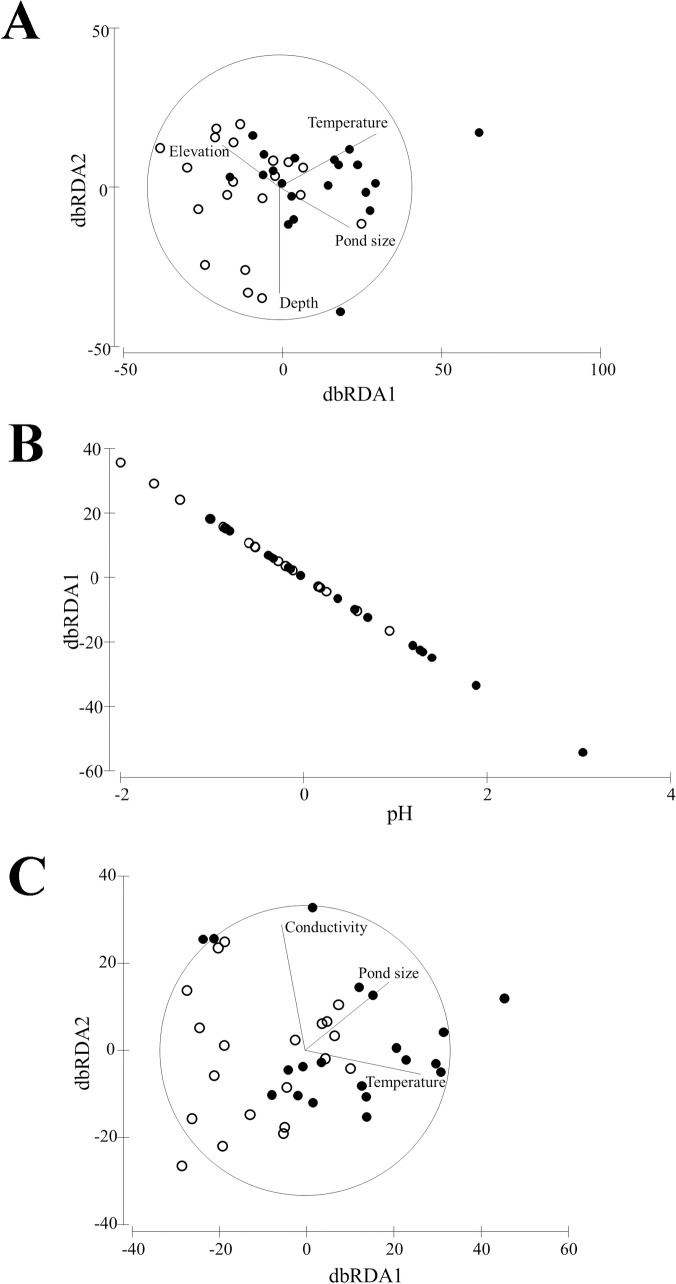
Distance-based redundancy analysis (dbRDA) results indicating significant effects of environmental variables on insect species composition.Vectors represent the effect of environmental variables on dragonfly (A), beetle (B) and bug (C) species composition between natural ponds (open circles) and artificial reservoirs (filled circles). Axes represent Bray-Curtis distance measure.